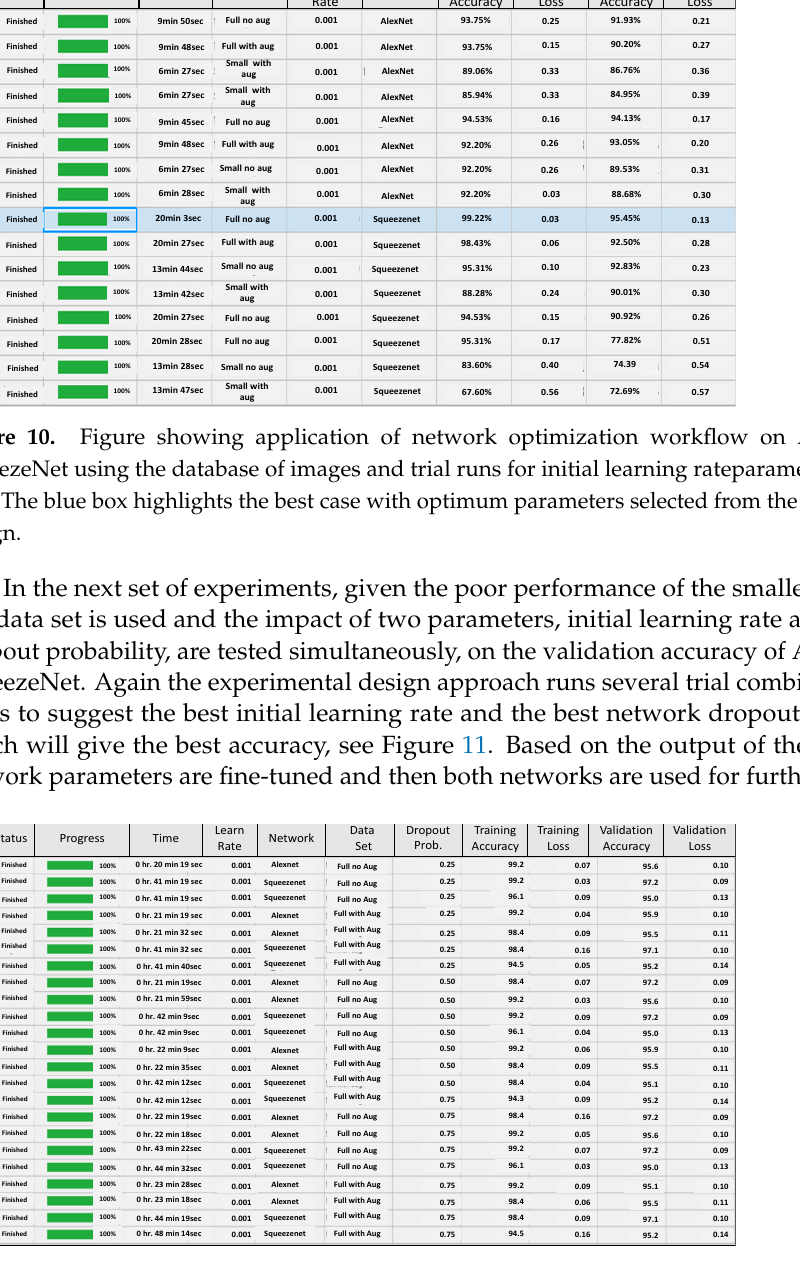
Figure 11. Figure showing application of network optimization workflow on AlexNet and SqueezeNet using the database of images and trial runs with Initial Learning rate and Dropout Probability